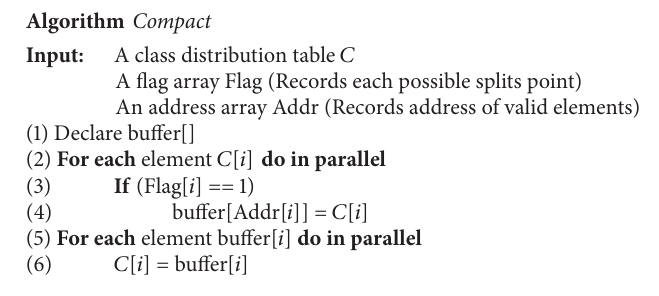
Algorithm 2: Algorithm of compact